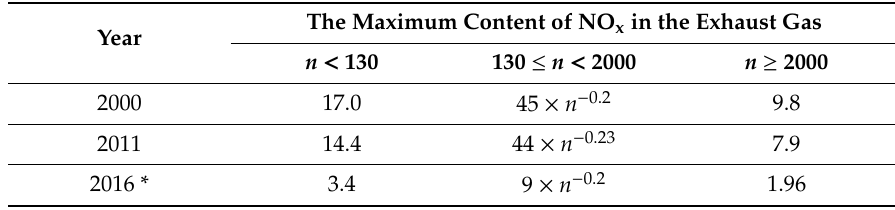
Table 1. The maximum content of NO x by MARPOL Annex